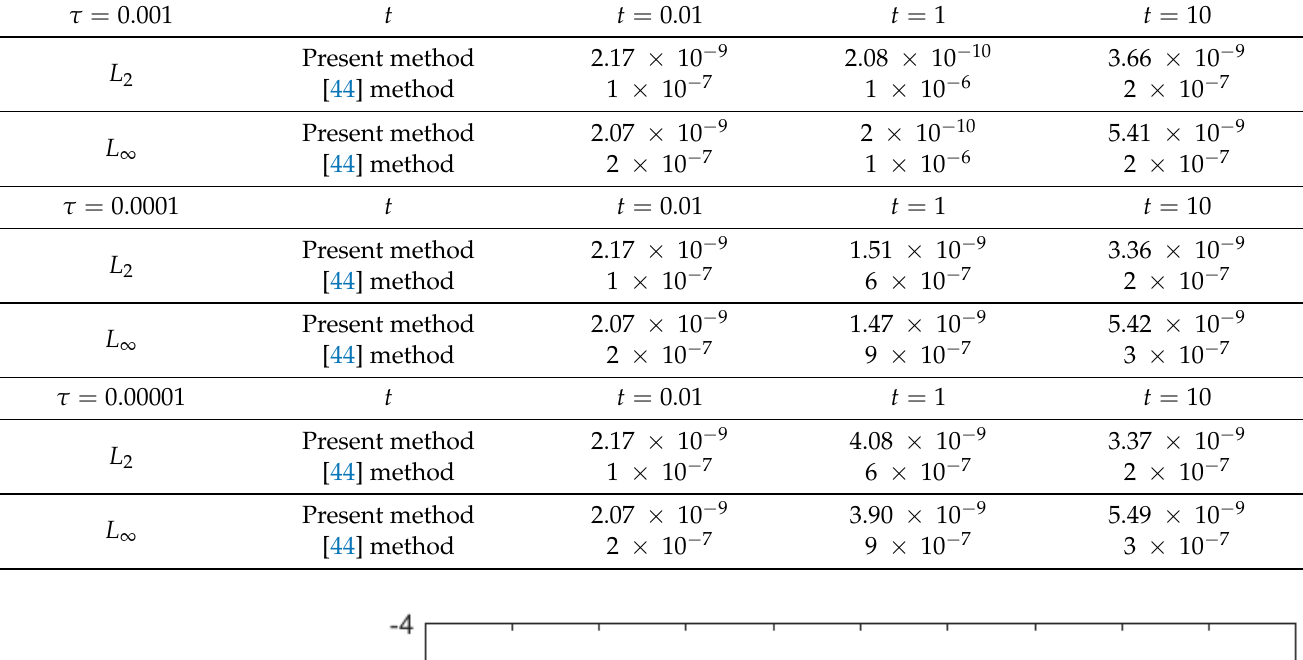
Table 2. The error norms L 2 and L ∞ of u ( x , t ) at different values of τ and µ = 0.75, for example, 1. τ = 0.001